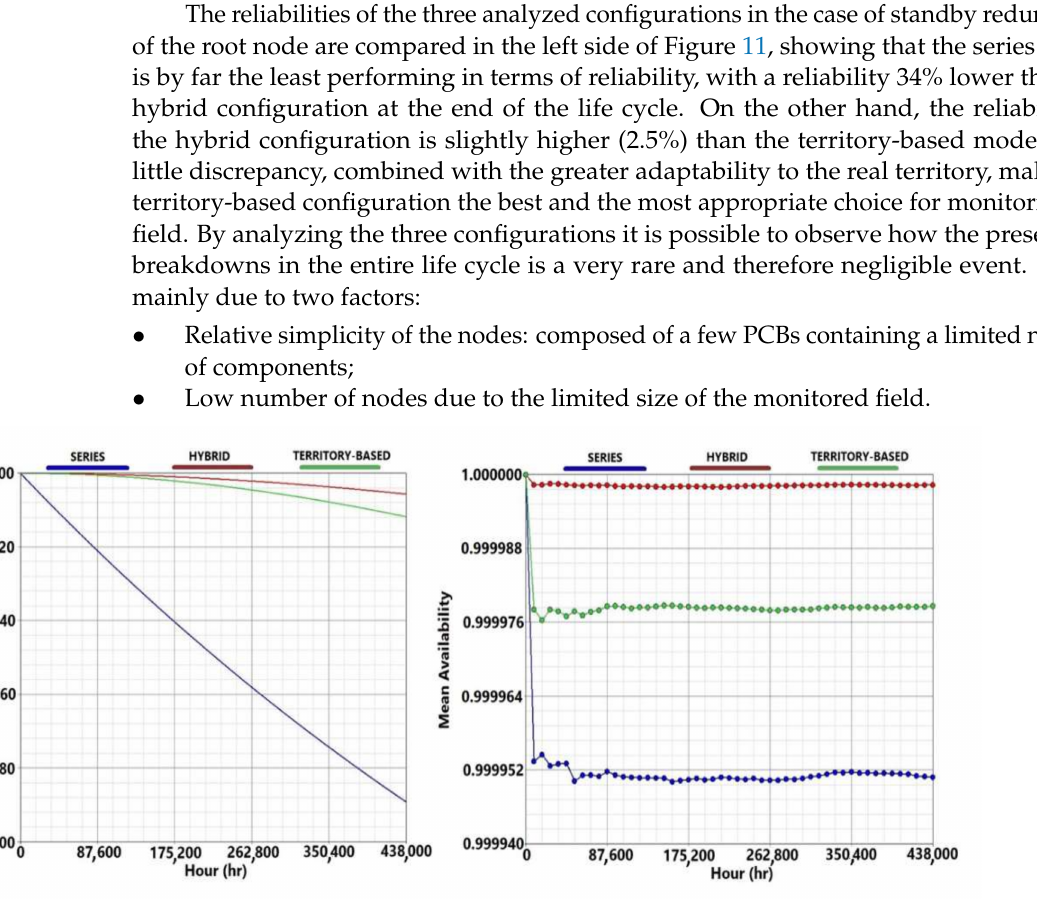
Figure 11. Results comparison between series model (blue lines), hybrid model (red lines) and territory-based model (green line). The left image shows the comparison of the system reliability, while on the right side the mean availability is